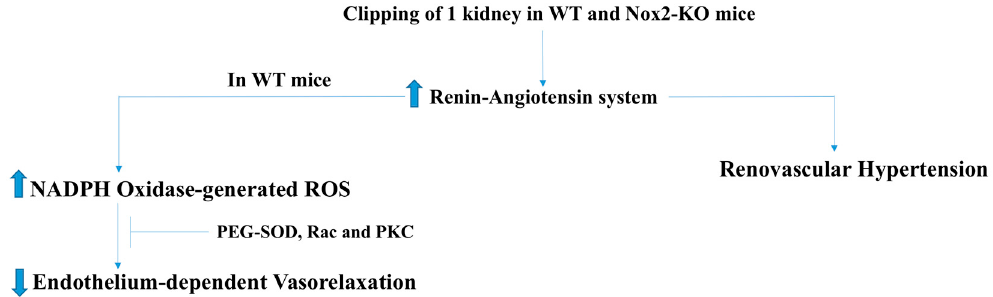
Figure 5. NADPH oxidase-derived ROS in renovascular hypetertension. Activation of PKC, Rac1, and tyrosine kinase receptors increases ROS production via activation of NADPH oxidase. ROS-induced inhibition of endothelium-dependent vasodilatation can be abrogated by inhibition of PKC, Rac, and EGFR kinase in renovascular animal model (using clipped WT mice), suggesting that activation of NADPH oxidase-derived ROS plays a crucial role in the development of renovascular hypertension. PEG-SOD: Polyethylene glycol-conjugated superoxide dismutase; WT: Wild type.